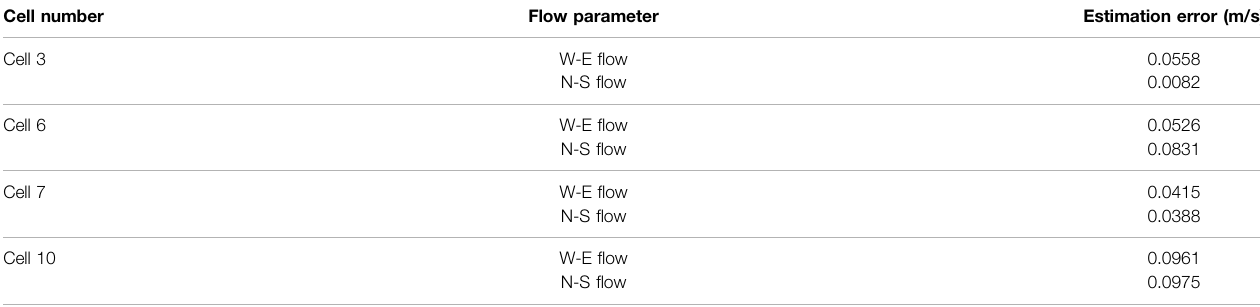
TABLE 1 | Root mean square error between the estimated and the true fl ow parameters.